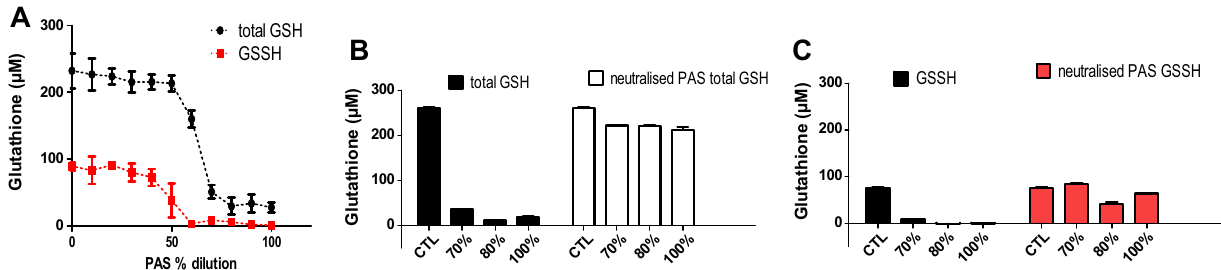
Figure 12. Measurements of total GSH and GSSH after 60 min exposure to PAS 20 and neutralized